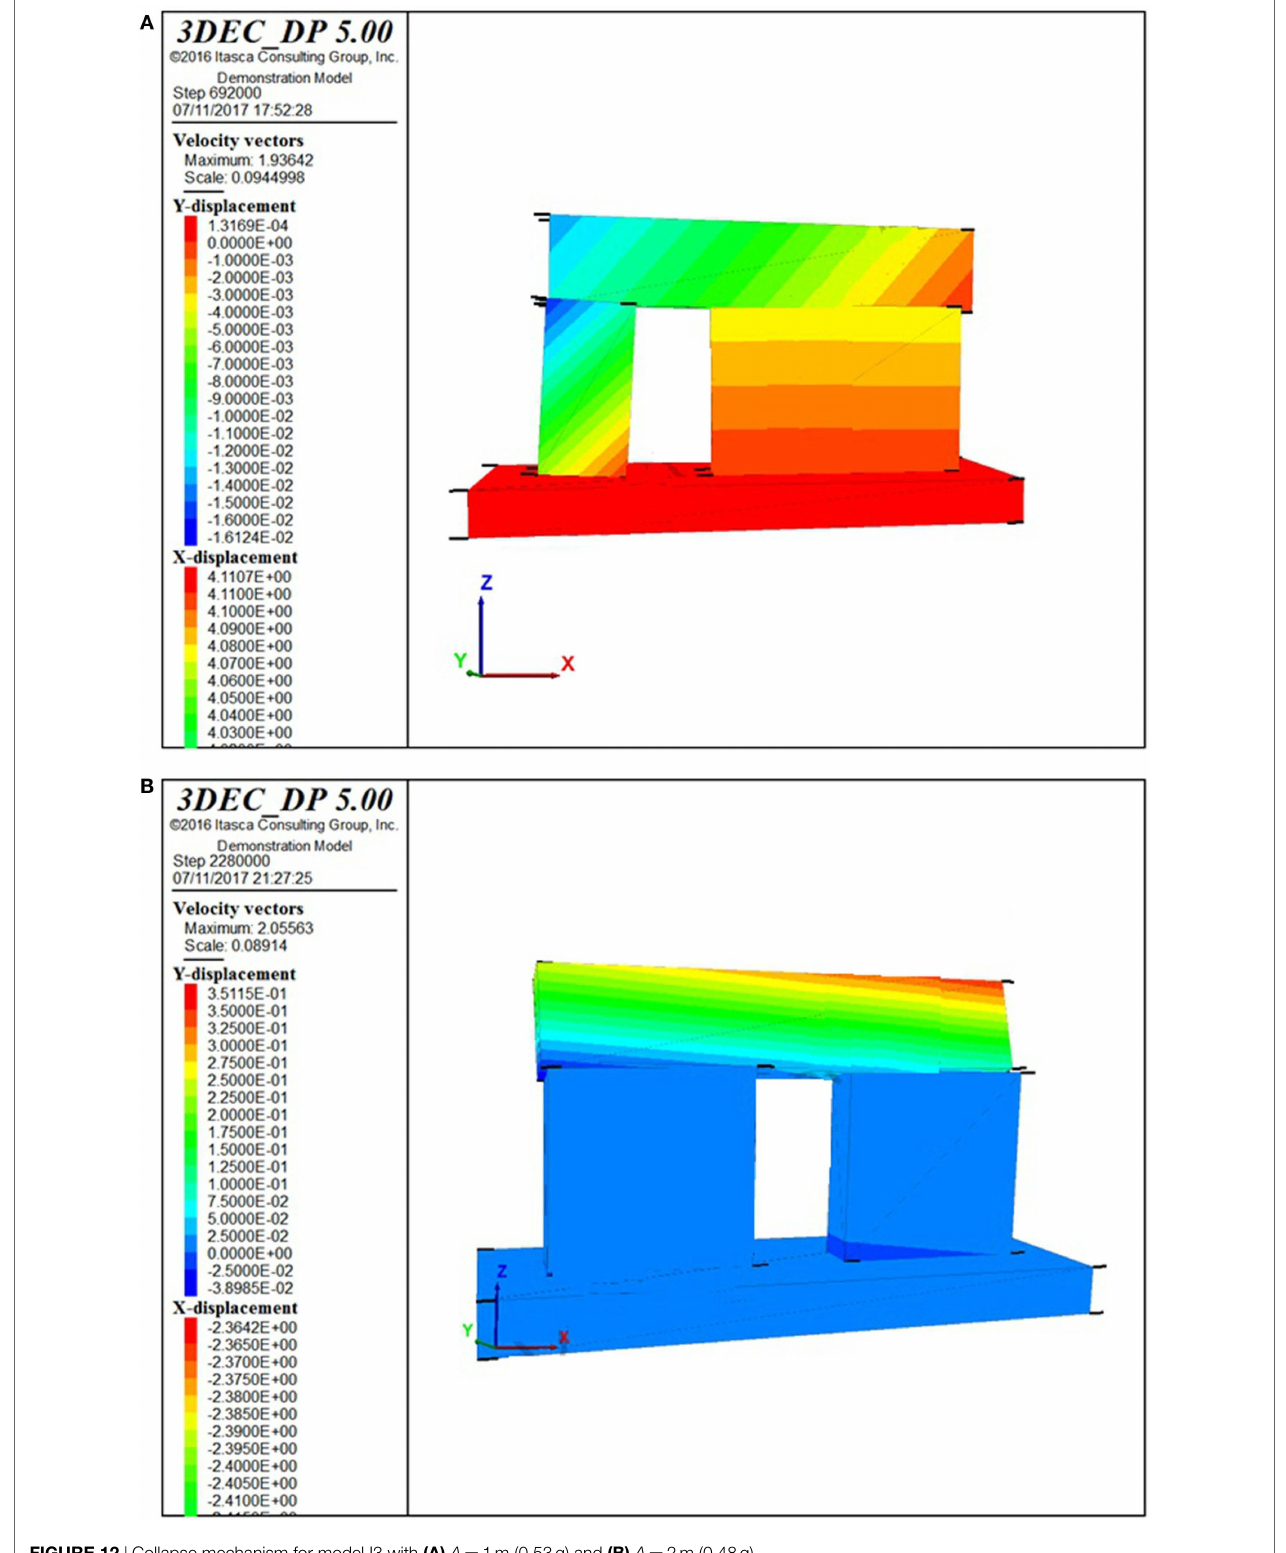
FIGURE 12 | Collapse mechanism for model I3 with (A) A = 1m (0.53g) and (B) A = 2m (0.48g).